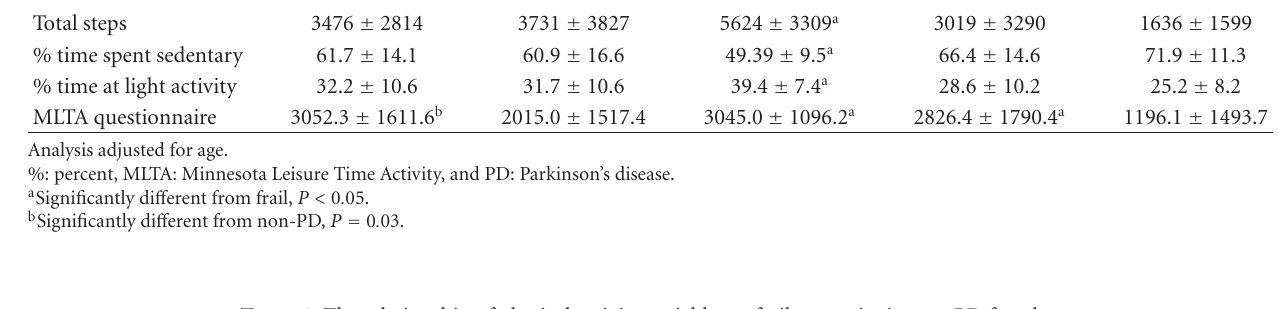
Table 3: The relationship of physical activity variables to frailty severity in non-PD females. ANOVA Spearman